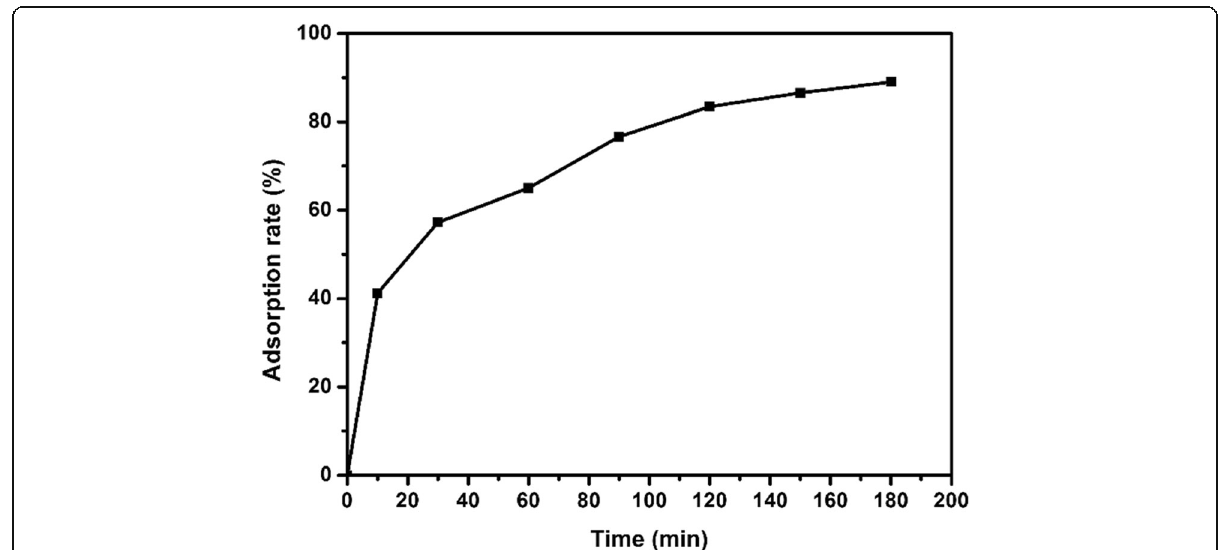
Fig. 8 Variation of adsorption rate of EE2 by nano-copper sulfide over time